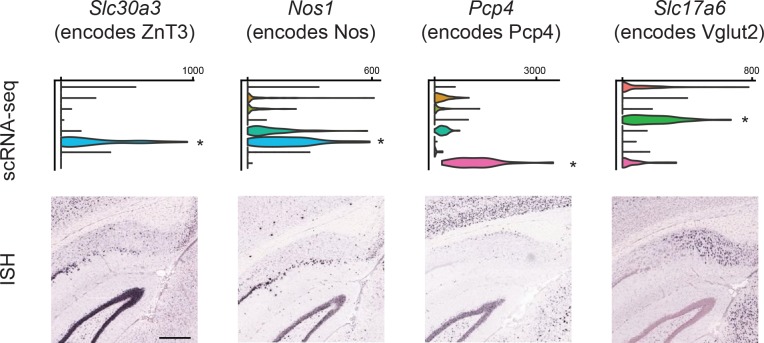
Examination of gene expression associated with immunohistochemically identified subdomains.Top row: names of four genes, and associated protein products, that have been previously shown to occupy spatial subdomains in the subiculum via immunohistochemistry (Ishihara and Fukuda, 2016). Middle row: scRNA-seq expression for all four genes across subclasses. Bottom row: ISH images for each gene in the dorsal subiculum. Asterisks indicate subclass-specific enrichment, defined as >3 fold enriched on average and pADJ <0.05. Scale bar: 400 μm.